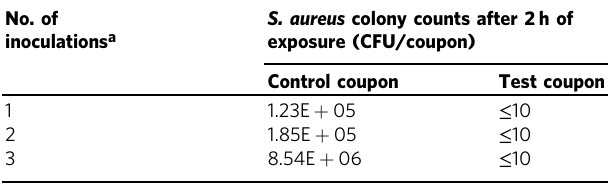
CFU colony-forming unit a Each inoculation adds ~2E + 07 CFU/coupon (at 0, 2, and 4h)